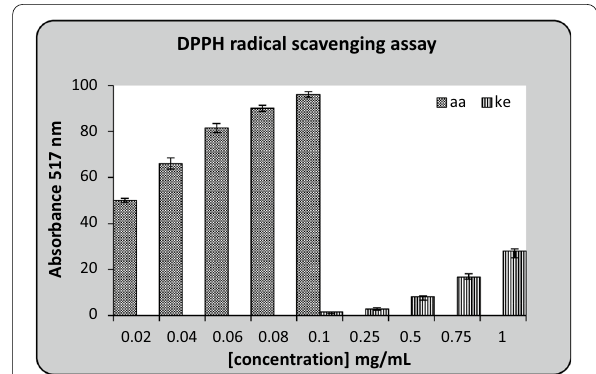
Fig. 1 DPPH free radical scavenging activities